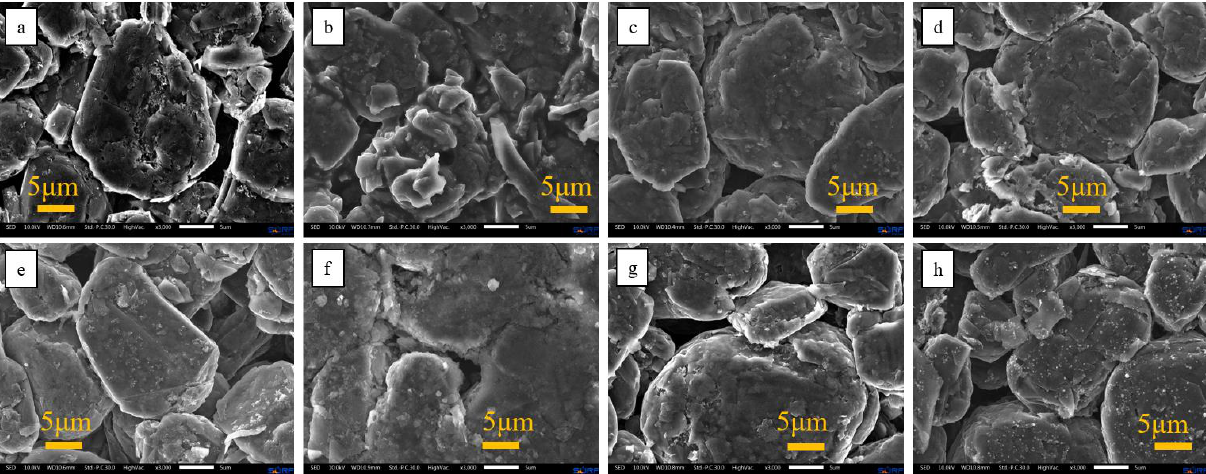
Figure 6. SEM pictures of the de-lithiated graphite anodes, showing the fresh electrode ( a ) and the electrodes after the formation cycles in the base electrolyte ( b ) as well as the electrolytes containing CIAC ( c ), MECI ( d ), CICL ( e ), CRAC ( f ), MECR ( g ), and CRCL ( h ).